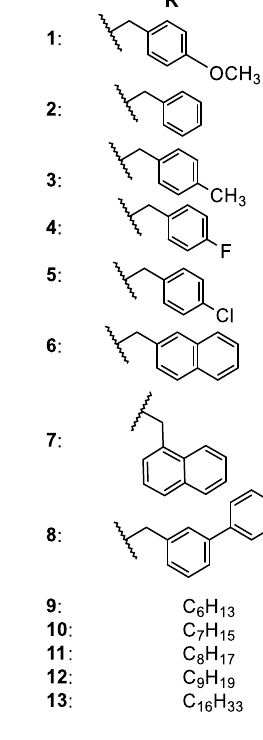
Figure 3. Structure of selected AKs.